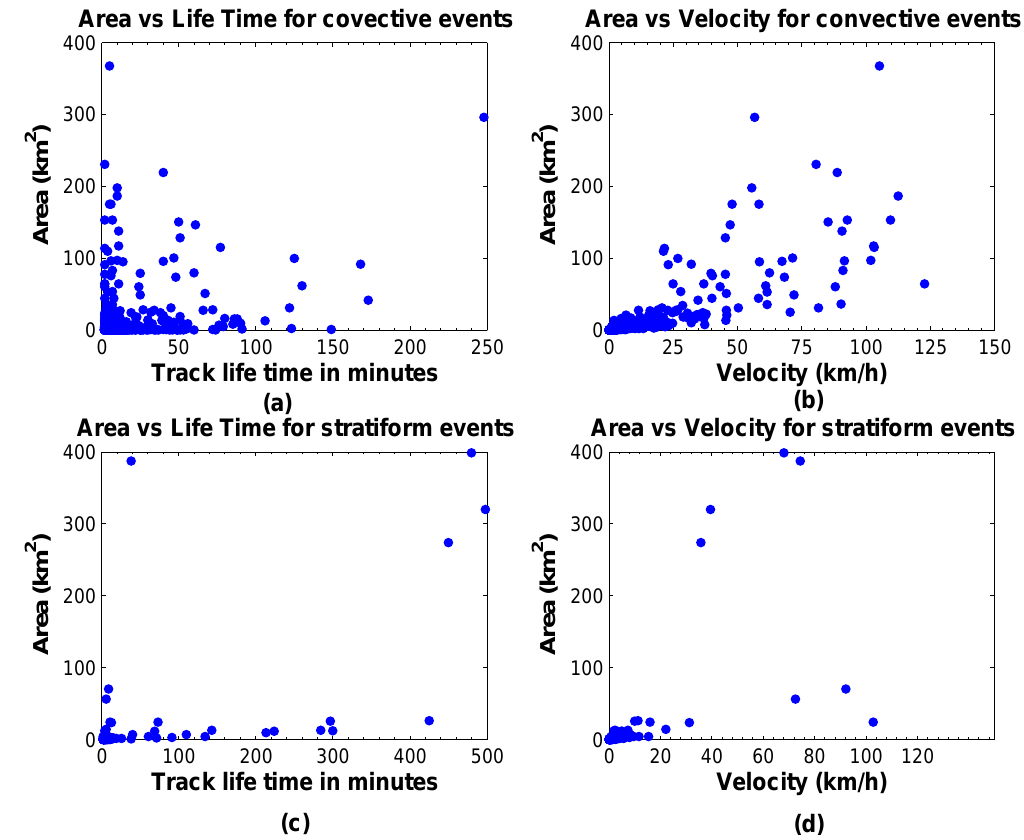
Figure 11. Scatterplots of area vs. life time and area vs. velocity for convective and stratiform